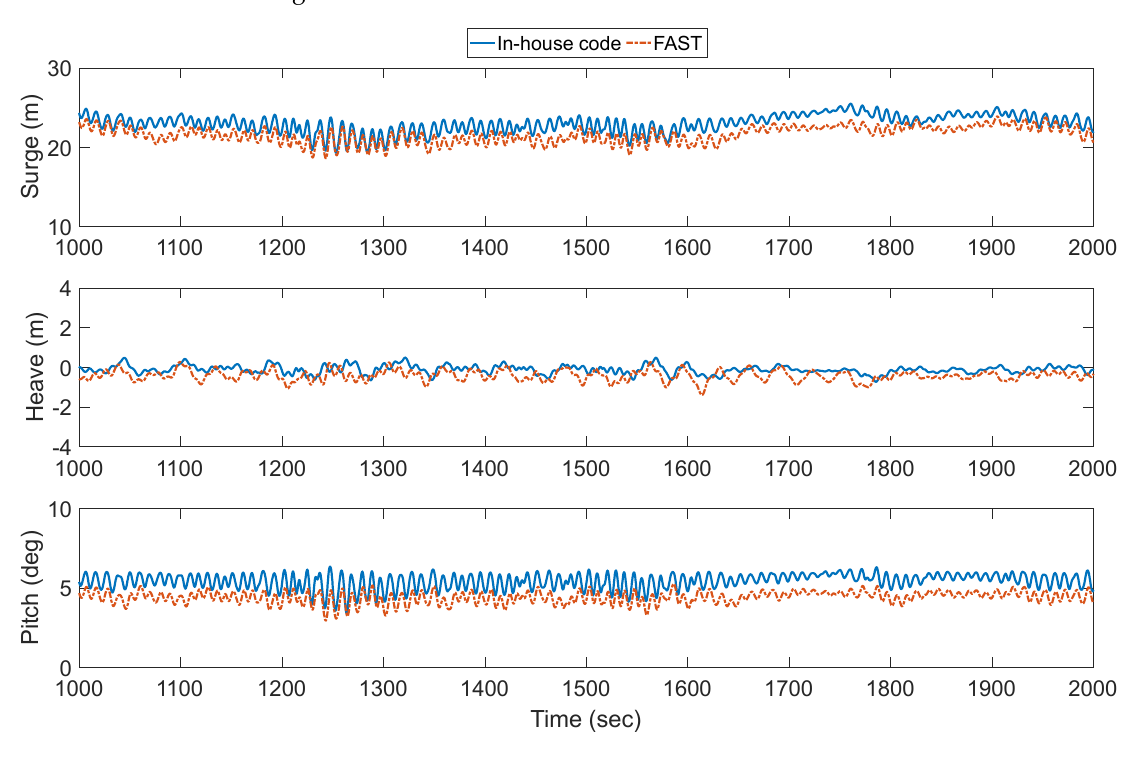
Figure 5. Time histories of the SPAR-buoy motion simulated by the in-house code and FAST.